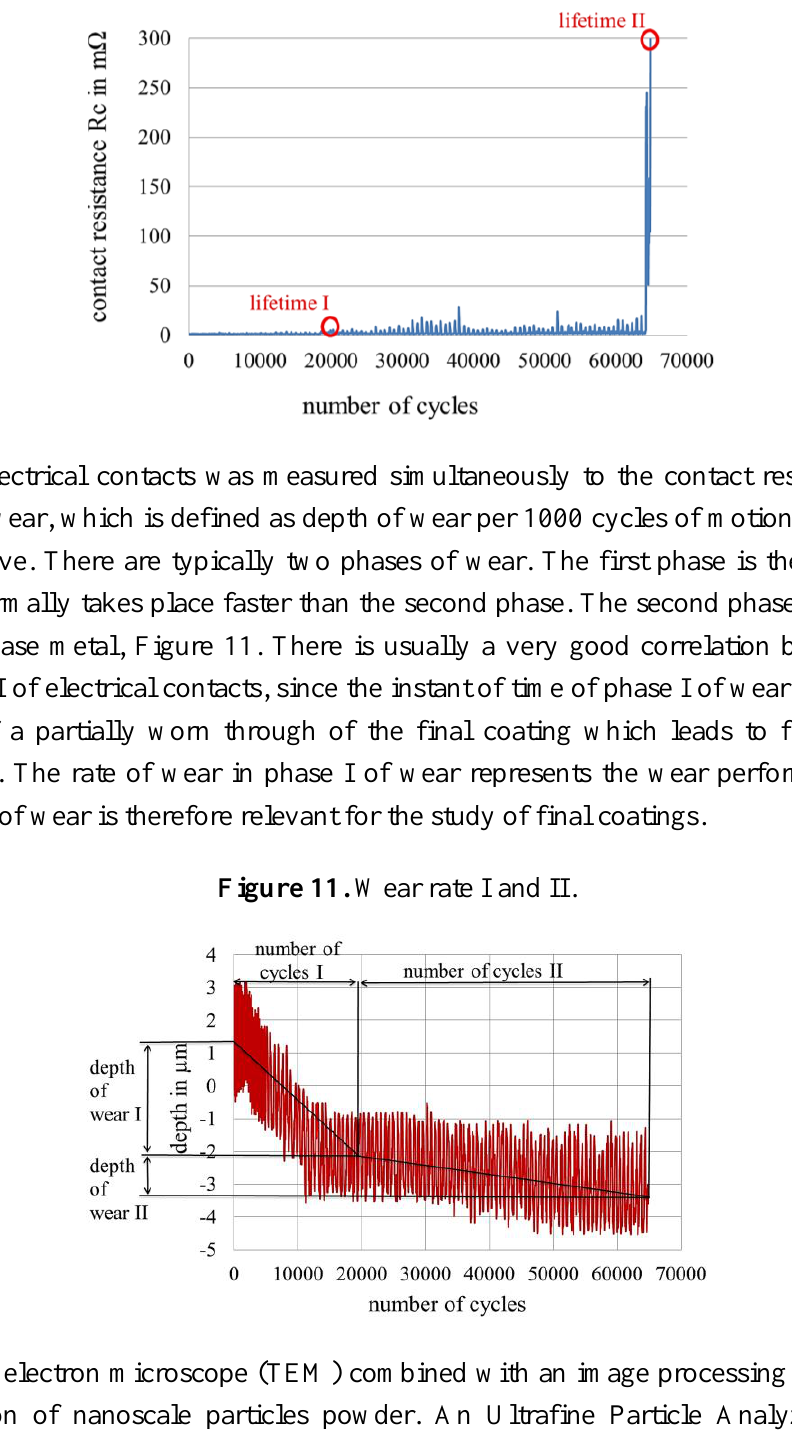
Figure 10. Increases in contact resistance due to fretting corrosion [31].